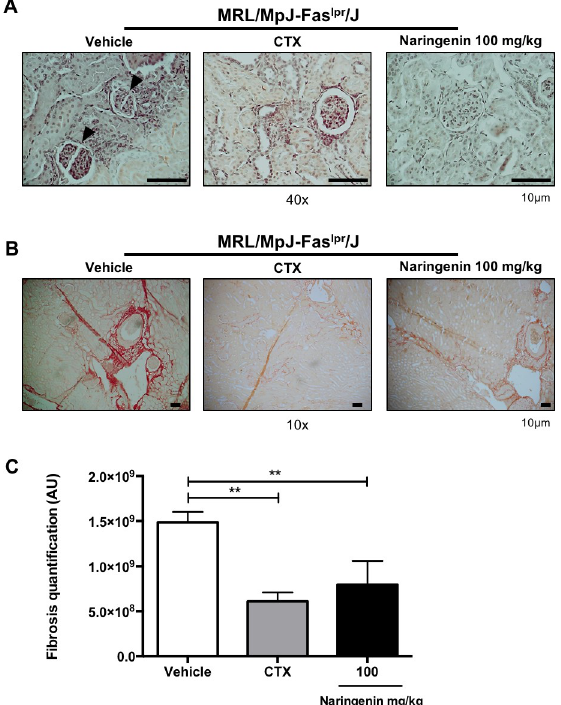
Fig 5. Naringenin treatment prevented kidney damage in MRL/MpJ-Fas lpr /J mice. Twelve-week-old MRL/ MpJ-Fas lpr /J mice were orally administered with Naringenin at 100 mg/kg every day for six weeks. Kidneys from each mouse were removed, paraffin embedded, sectioned and stained with H&E and PSR. (A) Mice under Naringenin treatment showed less kidney damage compared with vehicle group. Representative images from H&E-stained kidney sections. The arrows indicate the damage Bowman´s capsule. (B) Kidneys from mice treated with Naringenin and cyclophosphamide presented less fibrosis. Representative images from PSR -stained kidney sections (red show fibrosis). (C) Quantification of kidney fibrosis was performed using Image-ProPlus software. Data are presented as mean ± SD and statistical analysis was performed by one-way ANOVA followed by Tukey´s test. n = 3. �� p � 0.01 compared versus